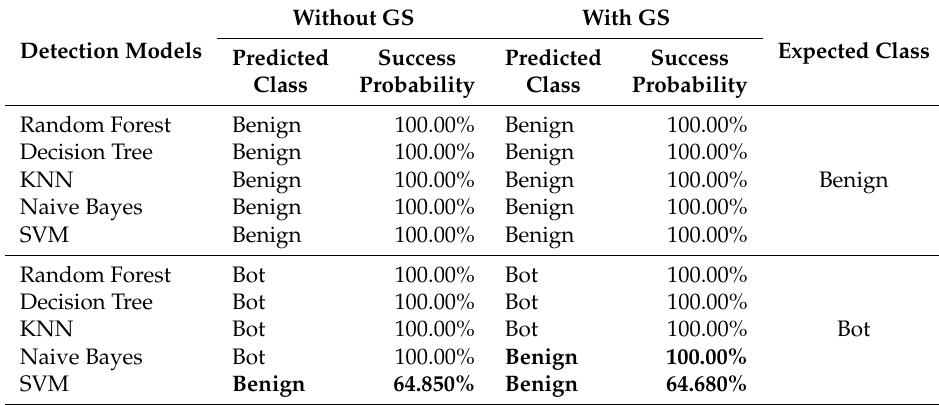
Table 10. Prediction results using the CIC-AWS-2018 dataset filtered by